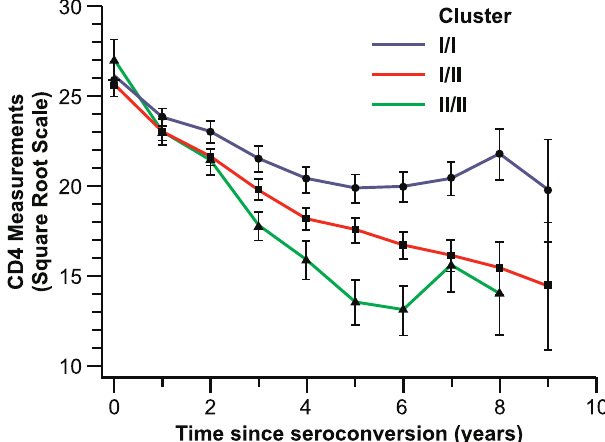
Figure 4. Arithmetic Mean of CD4 þ T Cell Counts over Time in the ALIVE Cohort by ctSNP5 (the Cluster) The observation period was from seroconversion to the censoring date of July 31, 1997. CD4 þ T cell counts were measured at 6-month intervals and were square-root transformed with standard error represented by the vertical